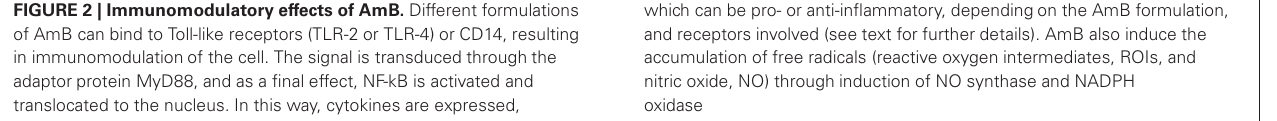
FIGURE 2 | Immunomodulatory effects of AmB. Different formulations of AmB can bind to Toll-like receptors (TLR-2 or TLR-4) or CD14, resulting in immunomodulation of the cell. The signal is transduced through the adaptor protein MyD88, and as a final effect, NF-kB is activated and translocated to the nucleus. In this way, cytokines are expressed,